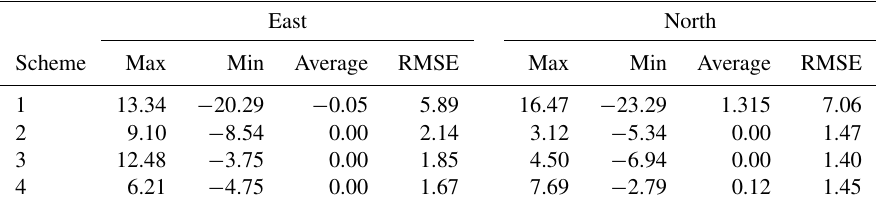
Table 6. External examination precision (mmyr − 1 ). East North Scheme Max Min